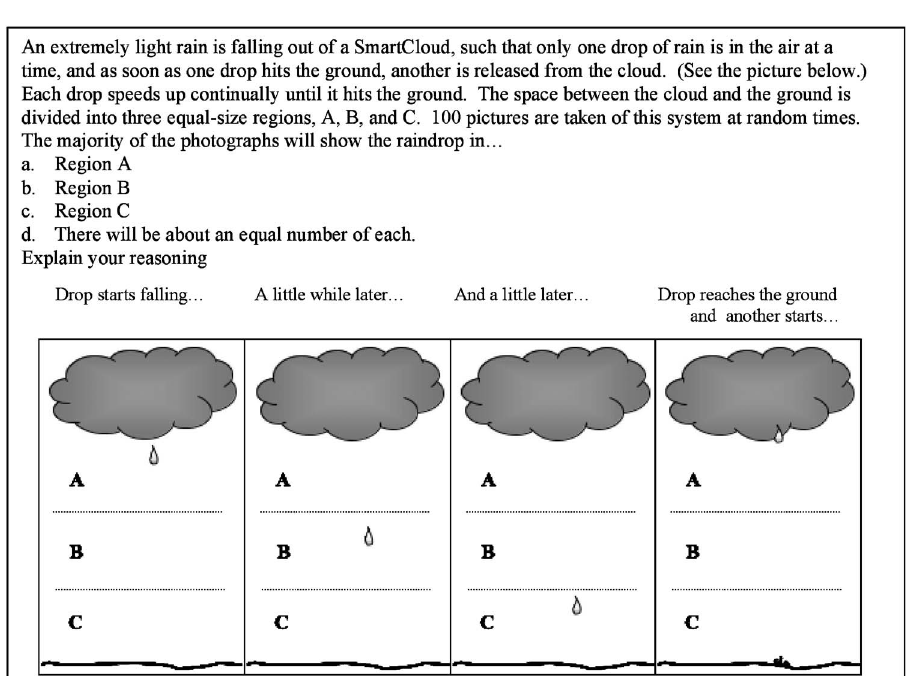
FIG. 6. Pre-test question on probability density. Students were asked to predict where a